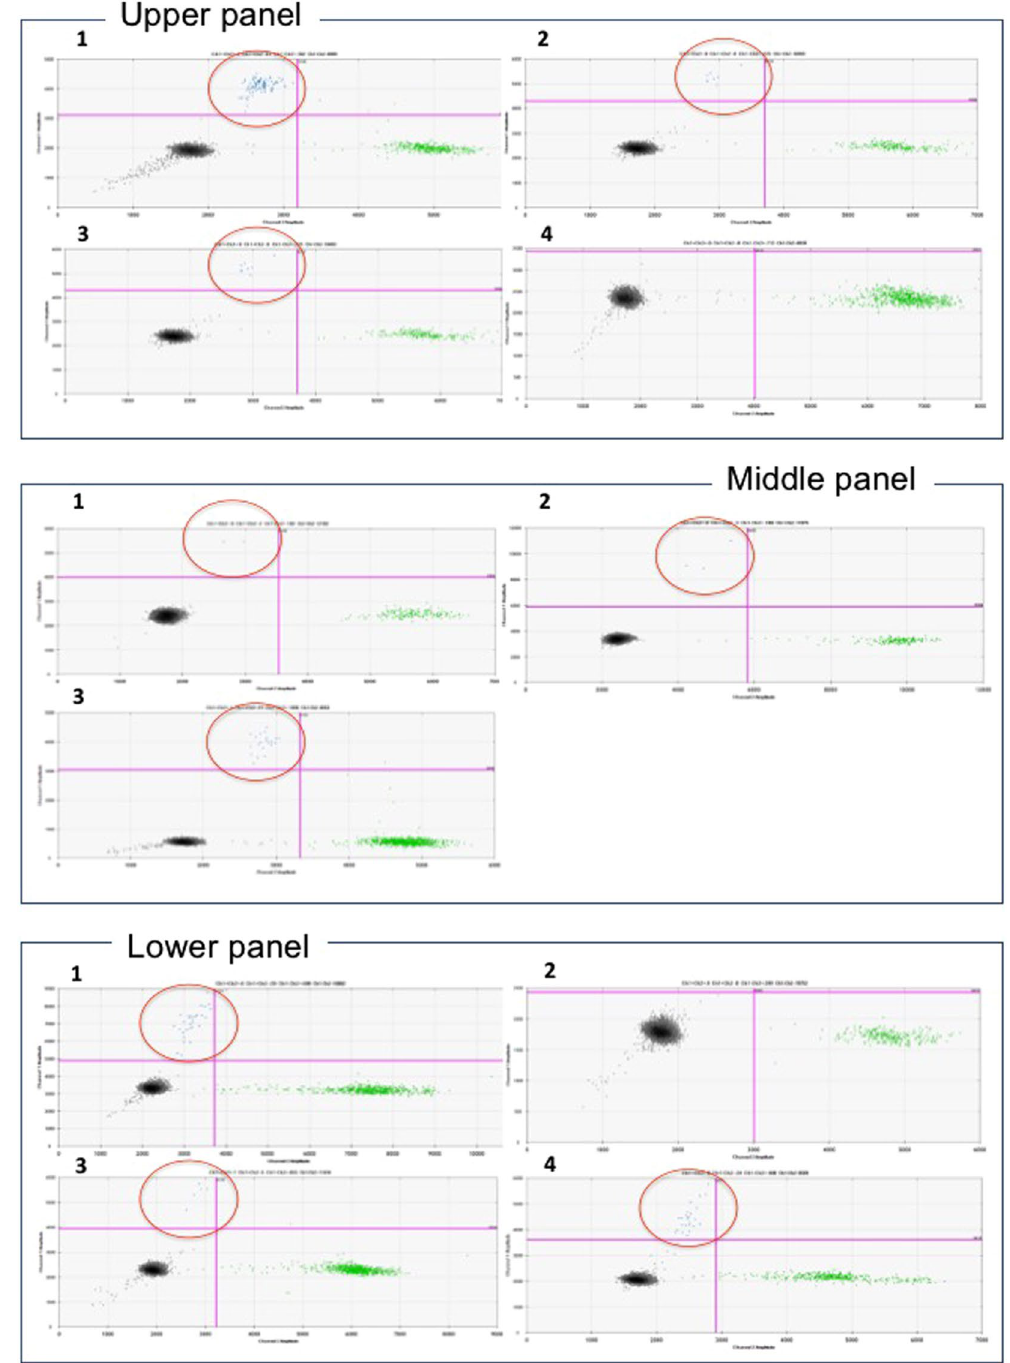
Figure 3. Representative ddPCR plots showing mut KRAS cftDNA variations during follow up of patients. The mut KRAS cftDNA are the blue dots circled in red. Upper panel : metastatic patient who developed PR to first-line FOLFIRINOX. (1) Baseline detection of KRAS p.G12D (11600 copies/ml); (2) p.G12D declined after 15 days (900 copies/ml); (3) p.G12D still reduced after 2 months (130 copies/ml); (4) pG12D is undetectable after 7 months of chemotherapy (0 copies/ml). Middle panel : patient with local recurrence who developed early PD during first-line FOLFIRINOX. (1) Baseline detection of KRAS p.G12D (240 copies/ml); (2) slight increase of p.G12D (245 copies/ml) after 15 days; (3) p.G12D increase (2700 copies/ml) after 2 months. This patient died due to PD two weeks after radiological re-evaluation at 2 months. Lower panel : metastatic patient who developed PR and subsequent early PD to GEMnPAC. (1) Baseline detection of KRAS p.G12D (3200 copies/ ml); (2) undetectable cftDNA at day 15 (0 copies/ml); (3) increase of p.G12D (900 copies/ml) after 2 months; (4) further increase of p.G12D (2800 copies/ml) corresponding to radiologically-confirmed PD at 4 months. Clinical condition progressively deteriorated and patients died because of PD 5 months after